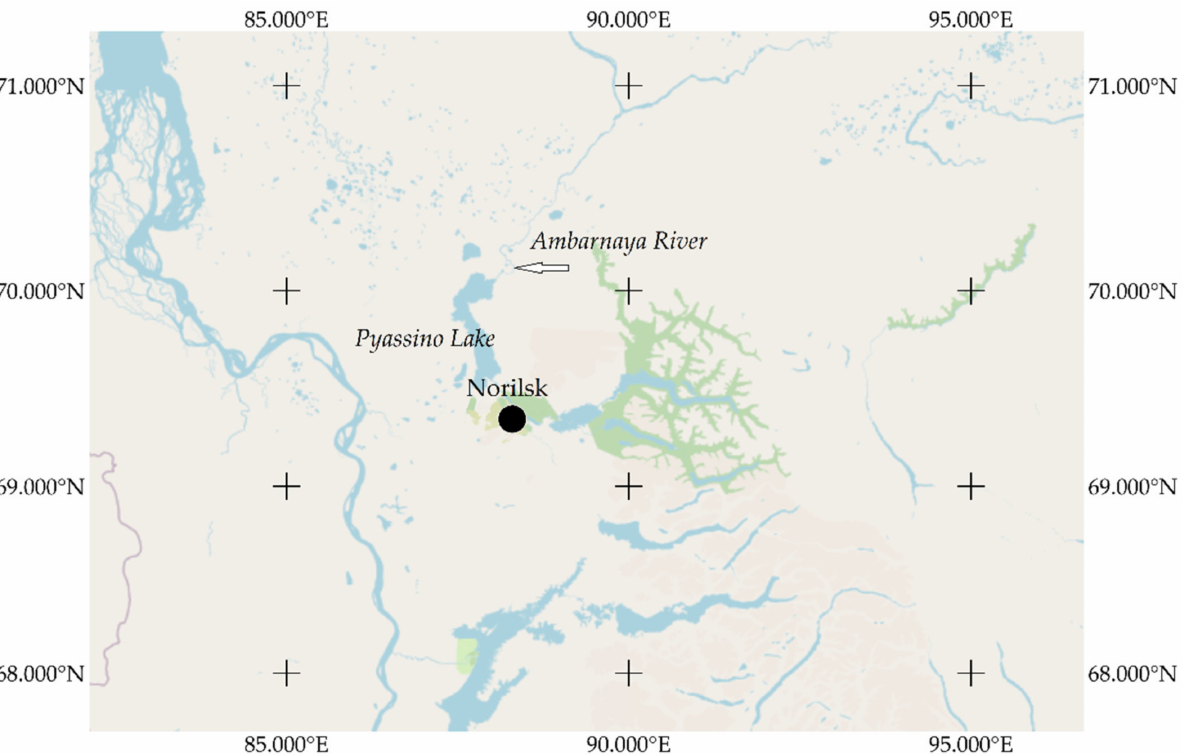
Figure 1. The study